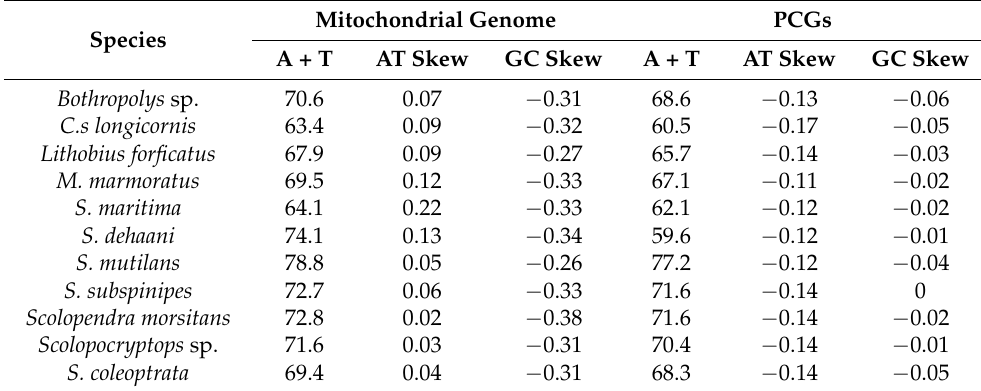
Table 2. Nucleotide composition of the mitogenomes and protein-coding genes of Chilopoda.